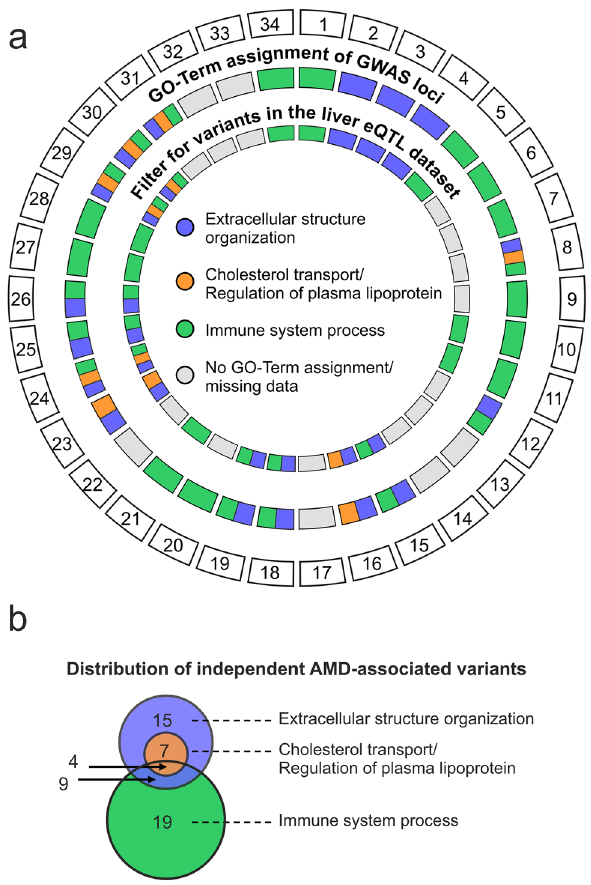
Figure 1. Categorizing independent AMD-associated variants. ( a ) AMD-associated loci as defined in ref. 2 were assigned to three biological pathways discussed to be relevant in AMD pathobiology, particularly the “Extracellular structure organization”, “Cholesterol transport” and “Regulation of plasma lipoprotein”, and “Immune system process”. A locus was assigned to a pathway if a gene located in this locus (locus definition: index variant(s) and proxies (r 2 > 0.5; +/- 100 kb) 2 is functionally associated by GO-Terms. Subsequently, the independent signals within these loci were correlated with the liver eQTL dataset reported by Strunz et al. 7 . ( b ) Distribution of independent AMD-associated variants over the three biological pathways identified. Overlapping circles indicate independent variants that were assigned to more than one category. Details are given in Supplementary Table